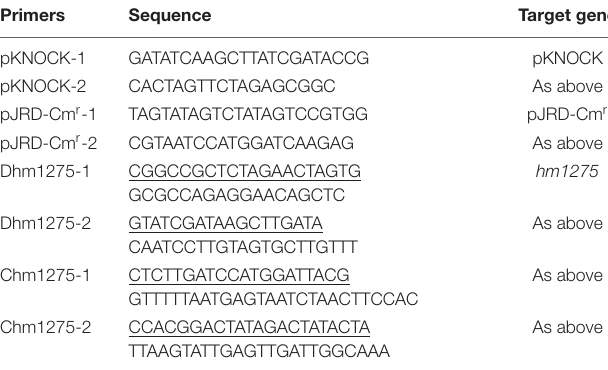
TABLE 2 | Primers used in this